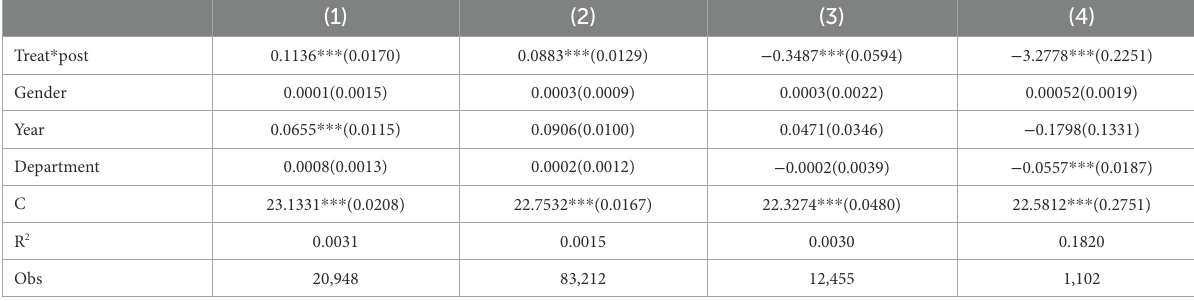
TABLE 9 Intervention organization mode heterogeneity effect